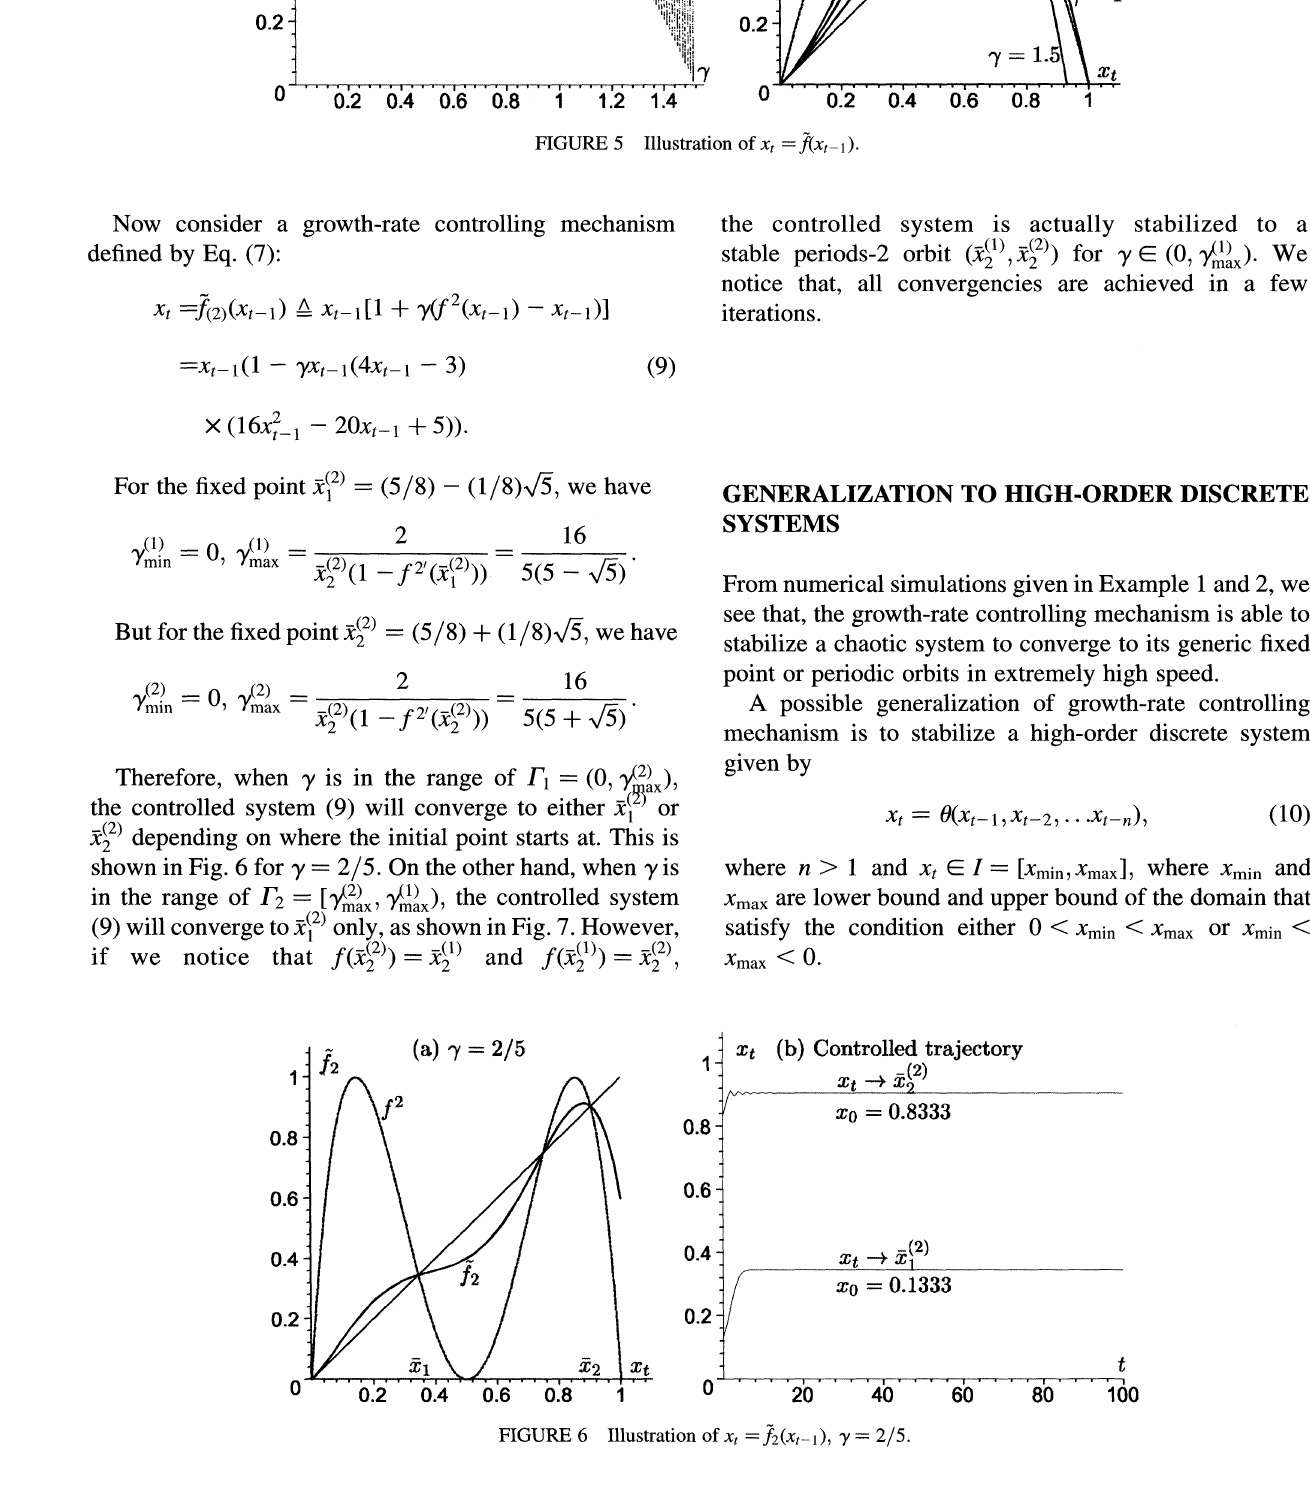
FIGURE 6 Illustration of Xt =2(Xt-1), 7"--